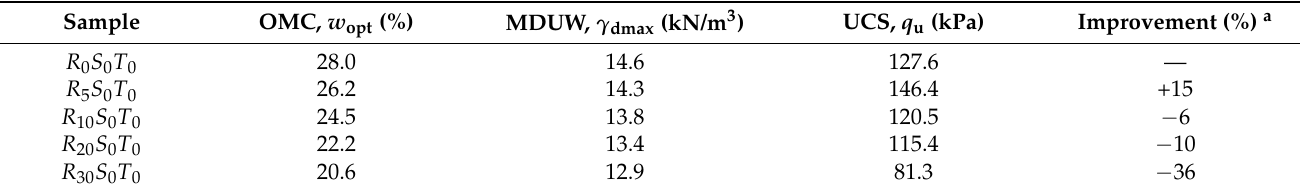
Table 3. Results of the SPE compaction and uniaxial compression tests for the untreated soil-GR blends—that is, R 0 S 0 T 0 , R 5 S 0 T 0 , R 10 S 0 T 0 , R 20 S 0 T 0 and R 30 S 0 T 0